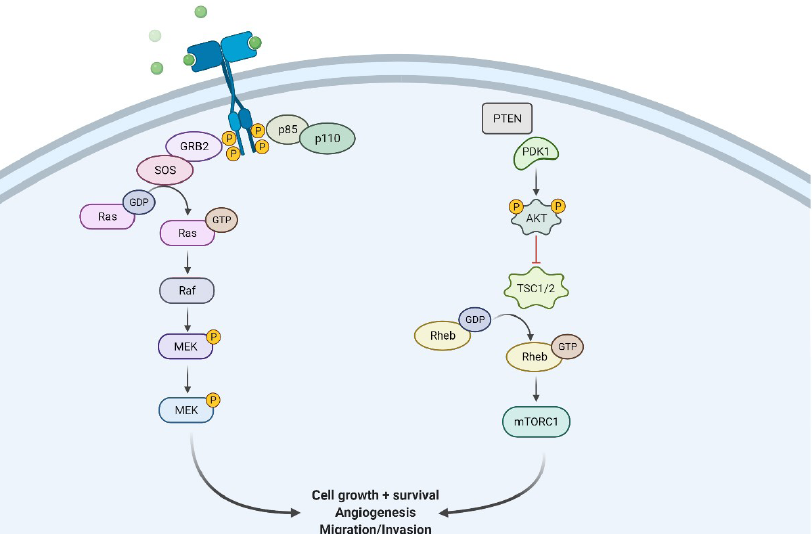
Figure 2. Illustration showing RTK/Ras/phosphoinositide 3-kinase signaling pathway at the site of GBM tissues. GRB2: growth factor receptor bound protein 2; SOS: son of sevenless; Raf: rapidly accelerated fibrosarcoma; MEK: mitogen activated protein kinase; PDK1: pyruvate dehydrogenase (acetyl-transferring) kinase isozyme 1; TSC1/2: tuberous sclerosis protein 1/2; Rheb: Ras homolog enriched in brain; mTORC1: mammalian target of rapamycin; P: phosphate